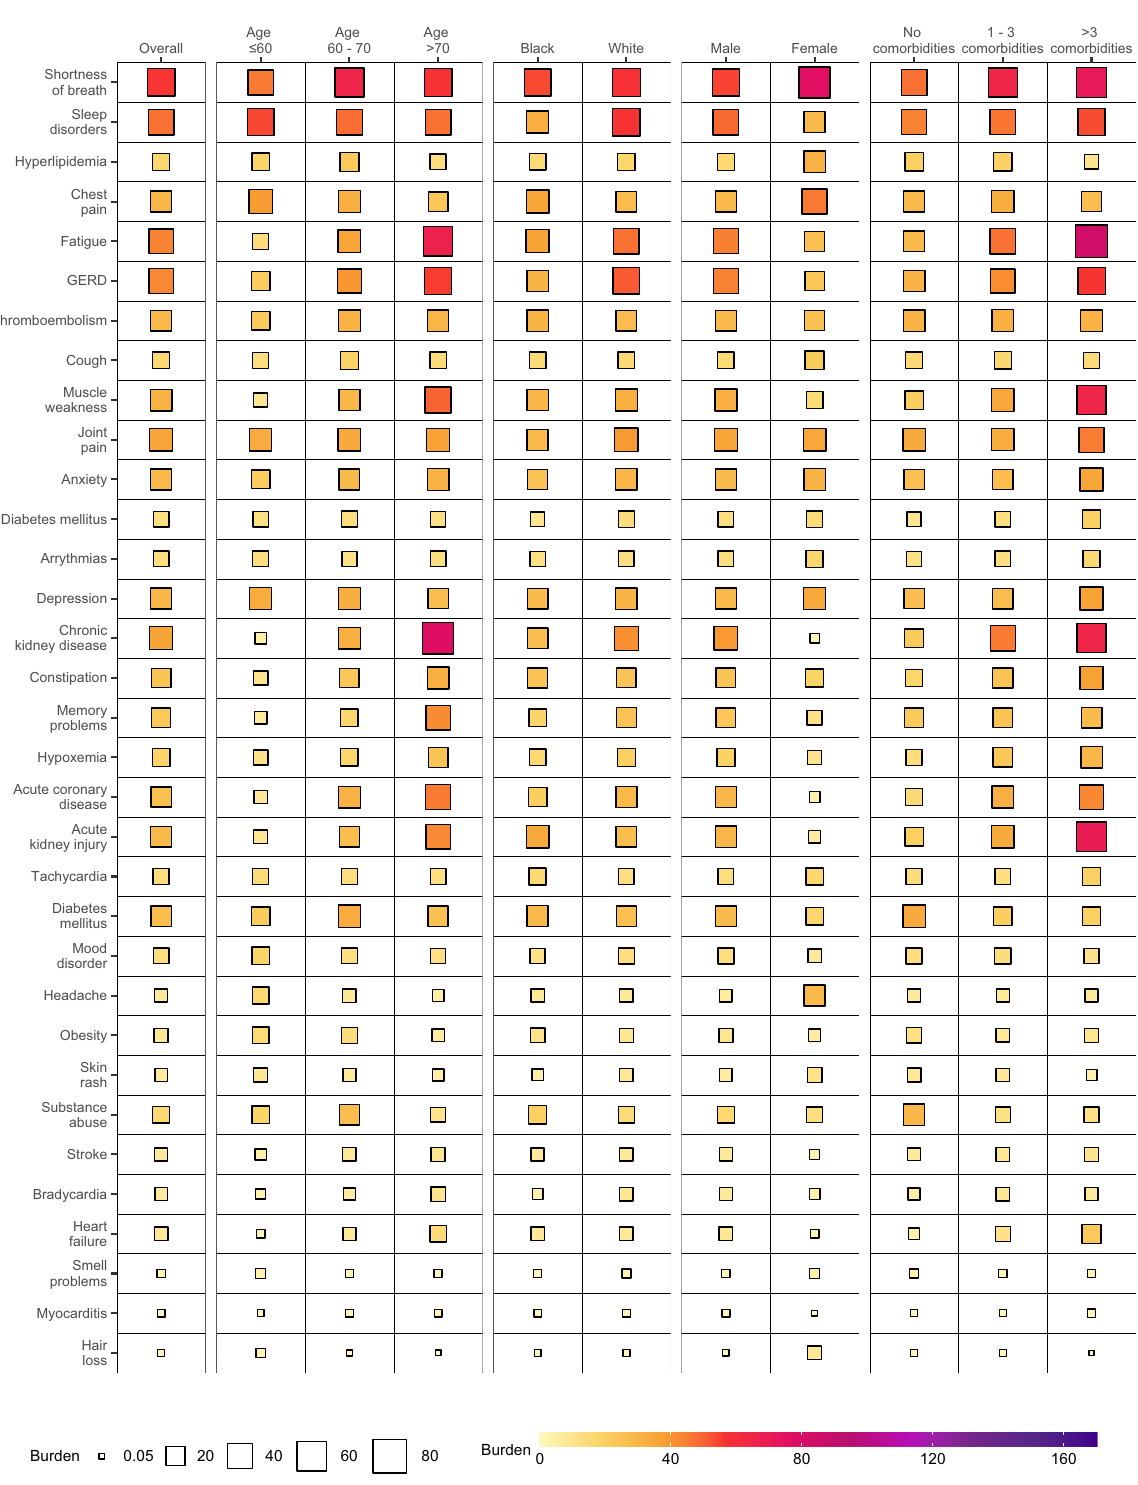
Fig. 6 Burden of post-acute sequelae of COVID-19 in the overall cohort and by age, race, sex, and health status in hospitalized COVID-19. Estimates of burdens per 1000 COVID-19 patients at 6 months are presented. The size of the square represents the burden within each care setting. The intensity of color from light yellow to deep purple represents the range of burdens across care settings. Models adjusted for age, race, sex, receipt of long-term care, Area Deprivation Index, number of outpatient encounters, number of hospital admissions, number of outpatient prescriptions, number of outpatient serum creatinine measurements, chronic lung disease, cancer, cardiovascular disease, cerebrovascular disease, dementia, diabetes mellitus, hypertension, hyperlipidemia, depression, anxiety, chronic kidney disease, hepatitis C and peripheral artery disease, overweight, obesity, smoking status, Charlson Comorbidity Index, US geographic region, total number of beds, number of COVID-19 tests administered, COVID-19 positivity rate, and average hospital bed occupancy during the week of participant enrollment when